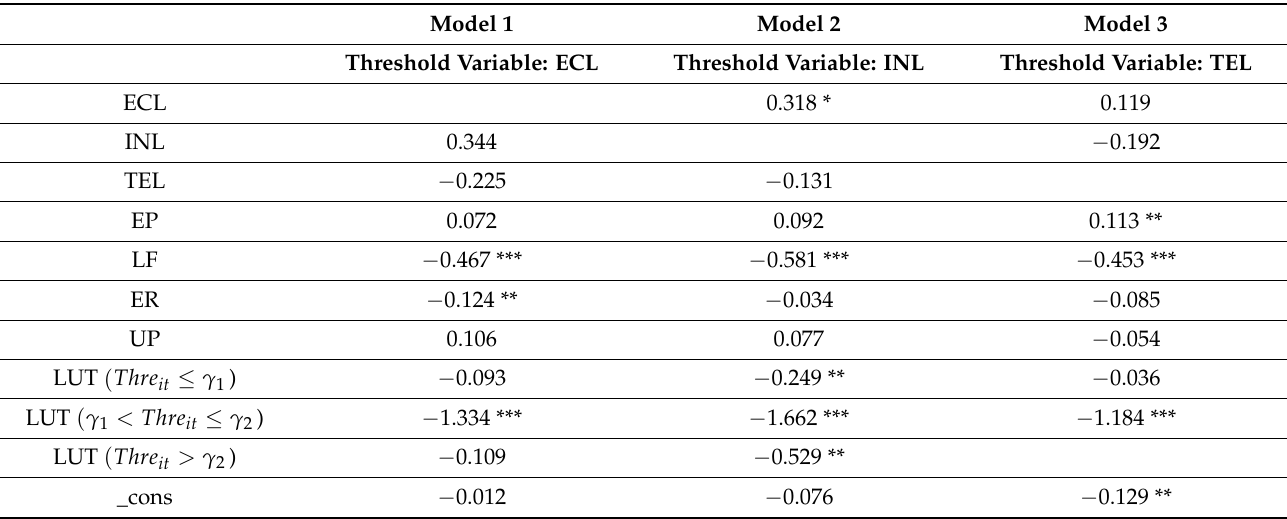
Table 6. Estimation of the threshold effects of carbon sink